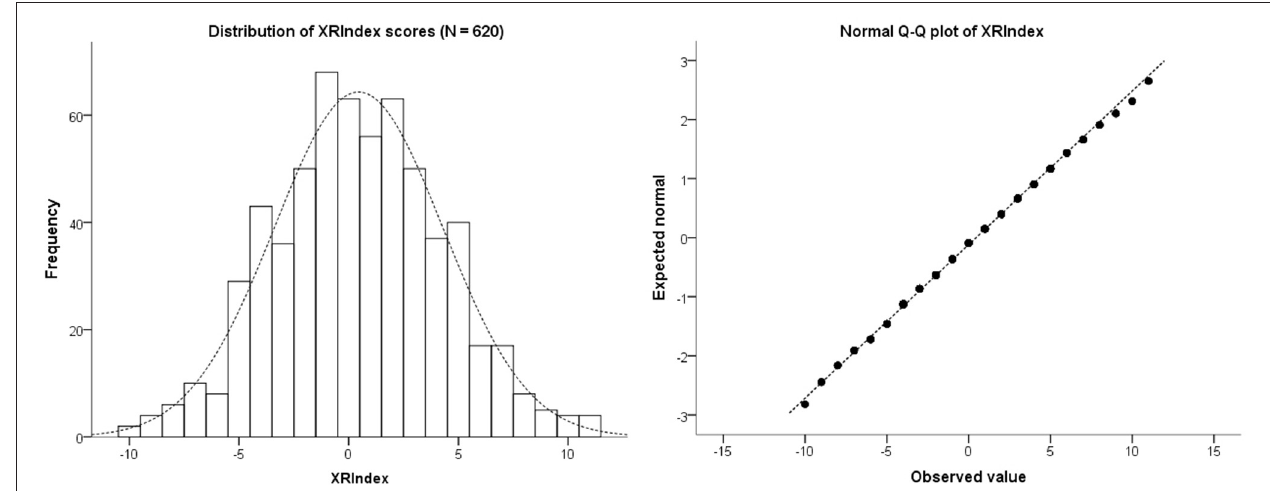
FIGURE 5 | The left hand panel shows a histogram of the distribution of scores for the XRIndex in 620 participants. The right hand panel shows the Normal Q-Q plot of the XRIndex distribution, which in its central part essentially overlaps with the normal distribution.